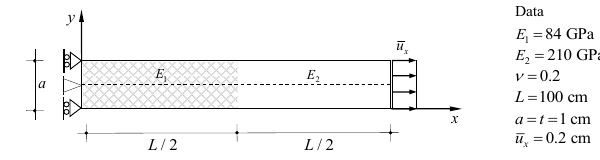
Figure 1: Bar-like structure in tension: geometry, loading, boundary conditions and material